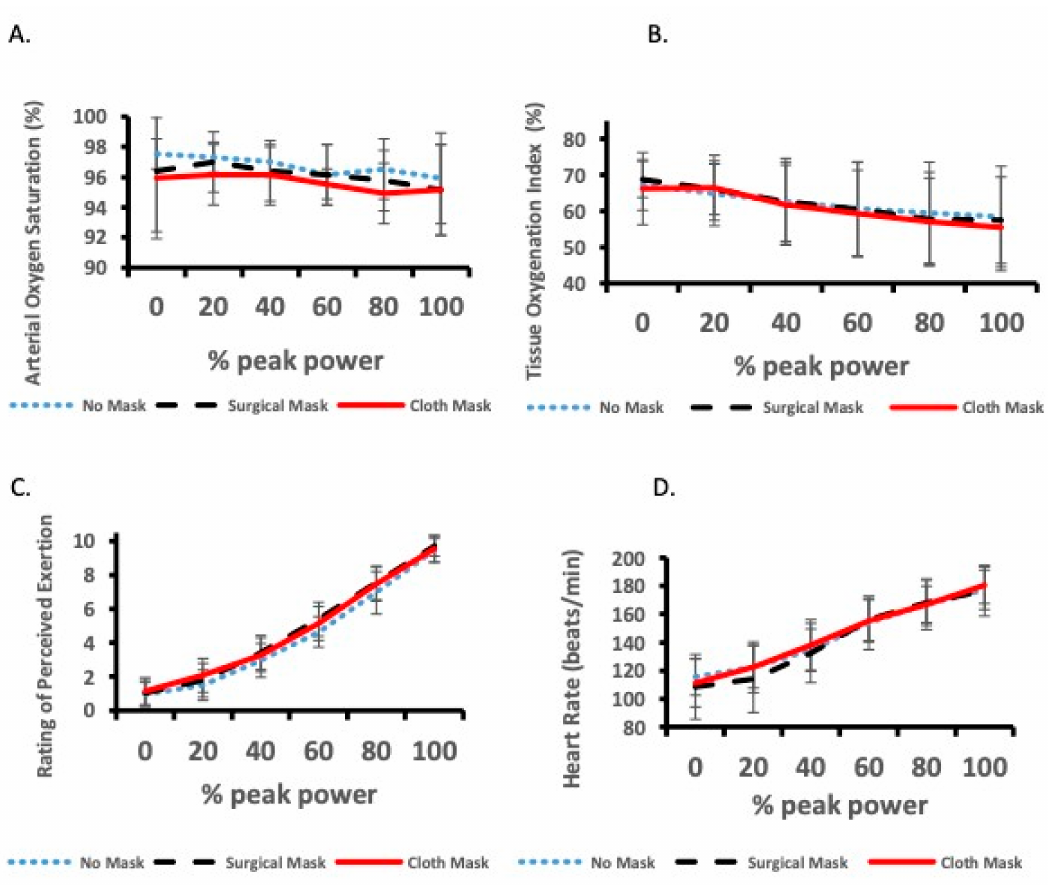
Figure 2. ( A )Arterialoxygensaturation,( B )muscletissueoxygenationindex,( C )ratingofperceivedexertion, and ( D ) heart rate expressed as percentage of peak power during the exercise test. All values are mean ±